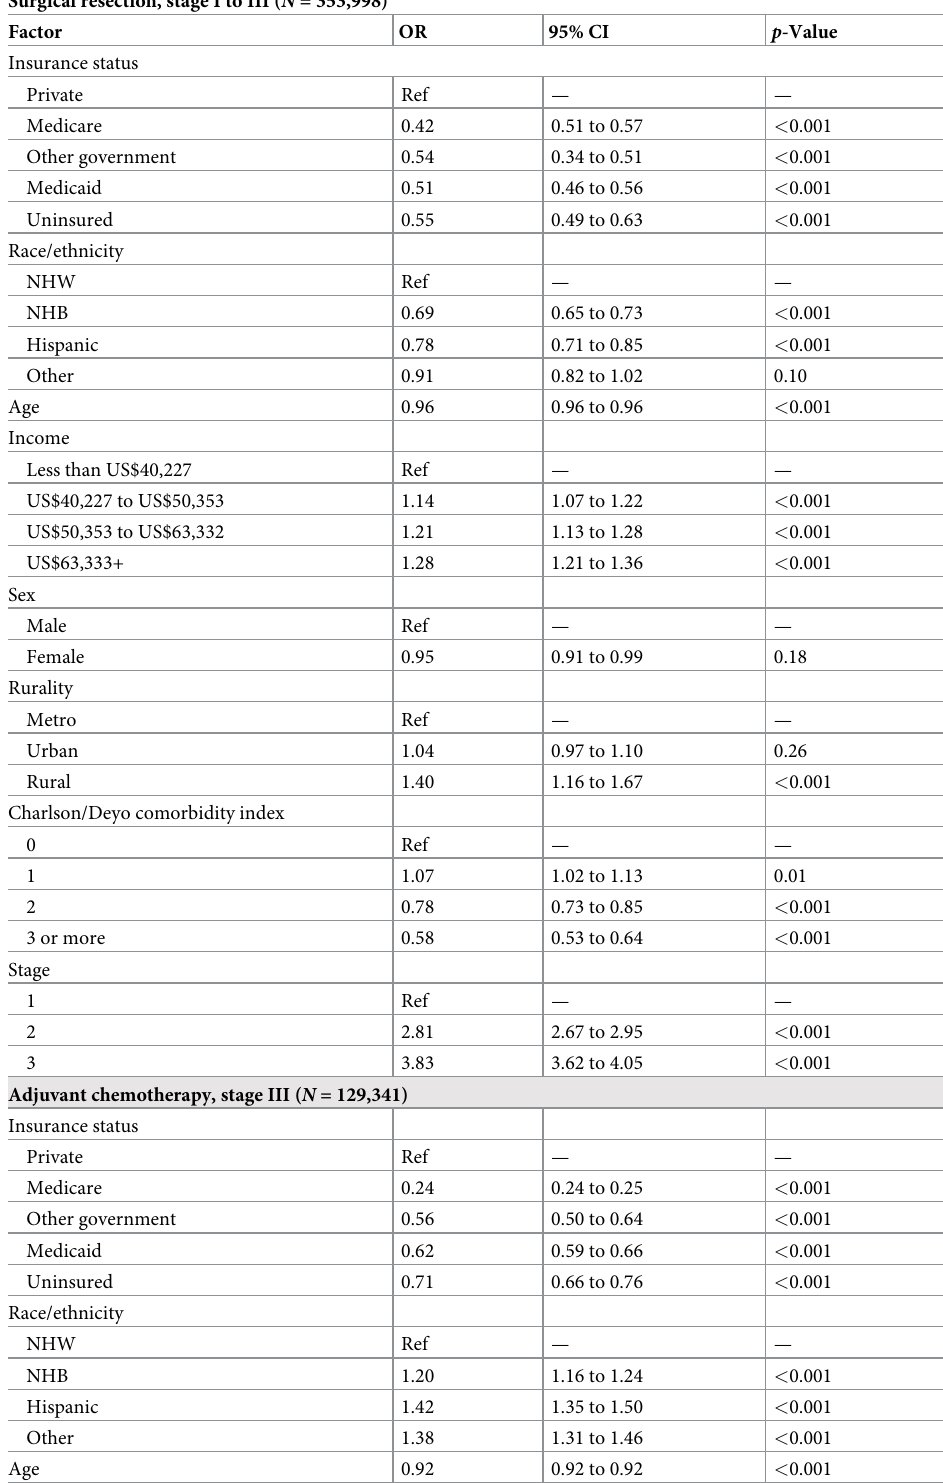
Table 3. Unadjusted odds of undergoing surgical resection or receiving adjuvant